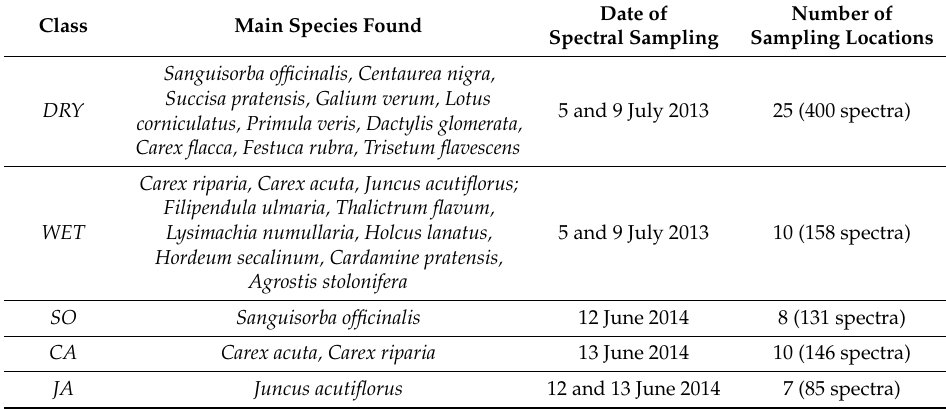
List of prominent species, grouped under vegetation classes, studied for spectral discrimination, including the final number of sampling locations (and spectra) after removal of poor-quality